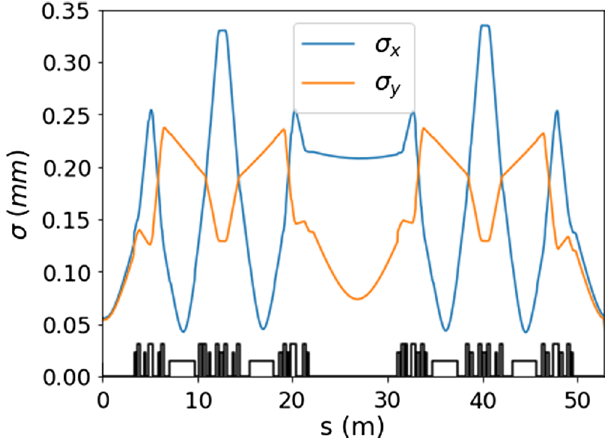
FIG. 12. Off-resonance scheme: horizontal and vertical beam sizes of one supercell.